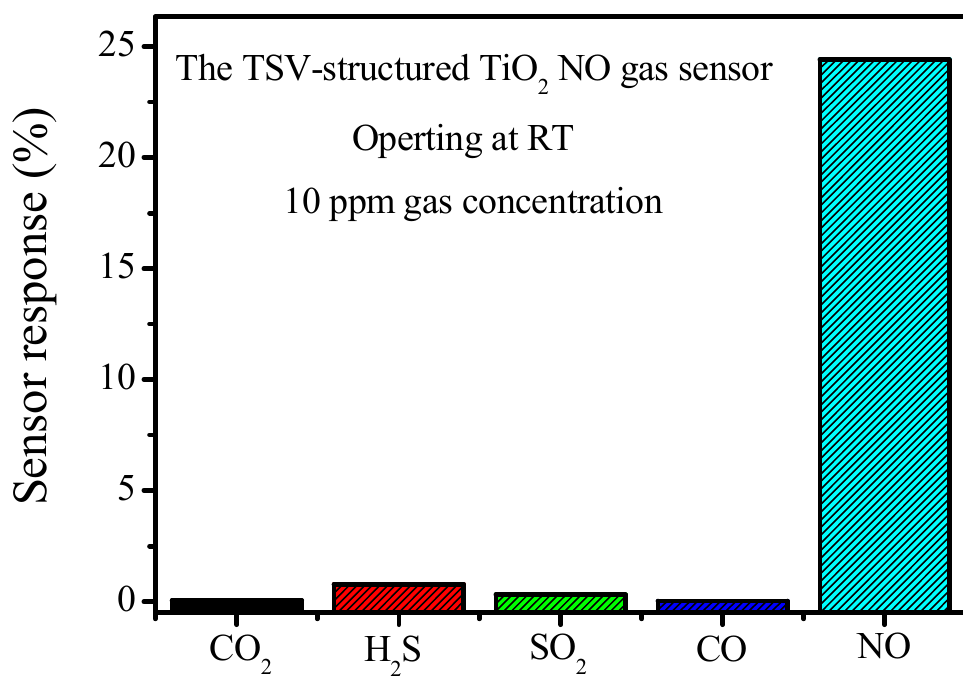
Figure 9. Gas measurements for a TSV-structured TiO 2 gas sensor.